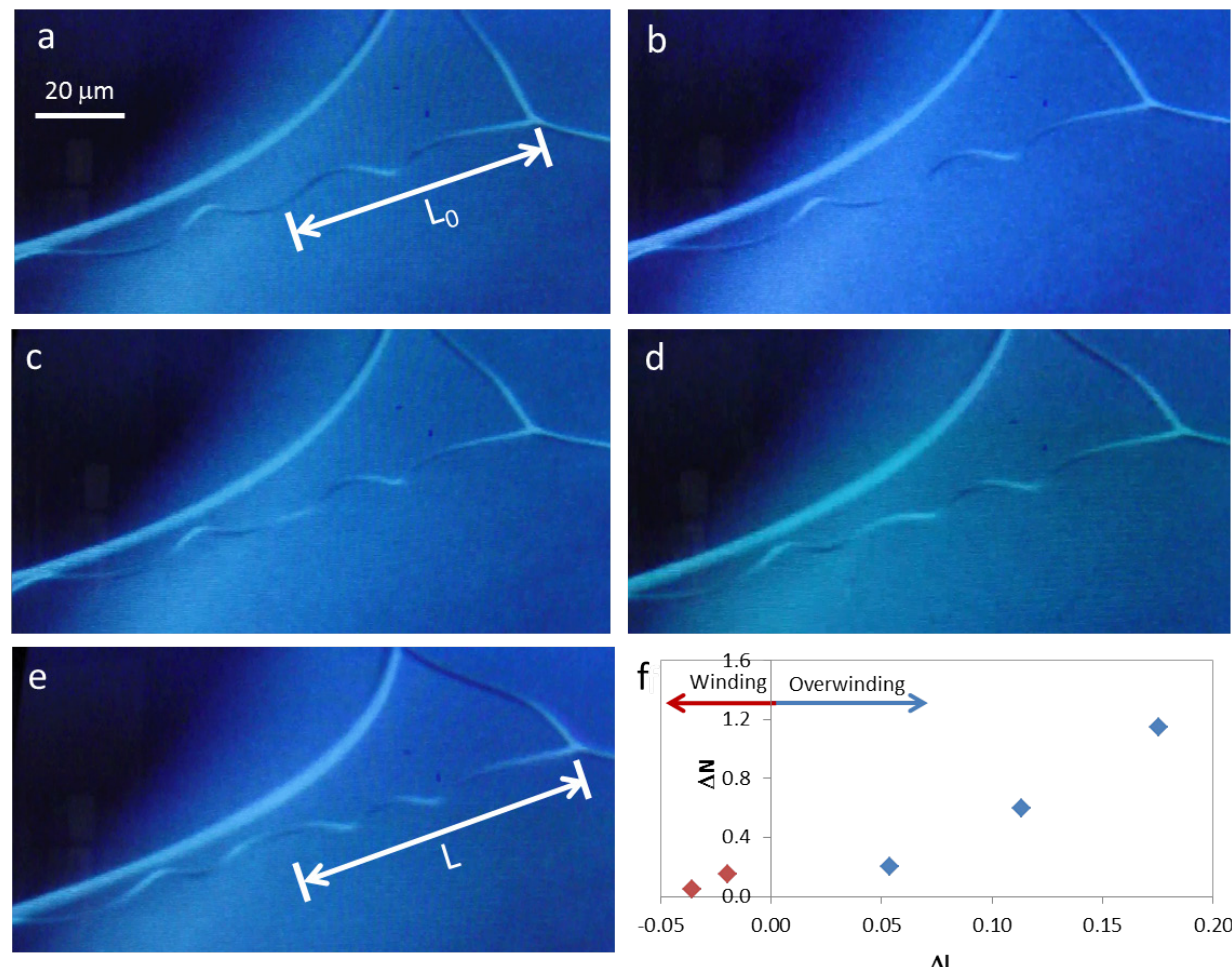
Figure 4. Winding and overwinding of a cellulose microfiber during SEM observation ( a ) to ( e ); ( f ) change in the number of turns present in each helix, ΔN, with scaled displacement,